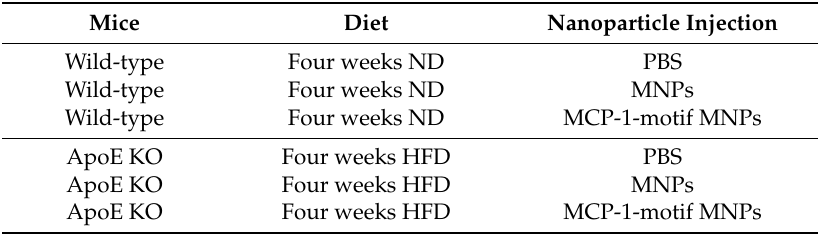
Table 2. Experimental design of animal model for in vivo imaging system